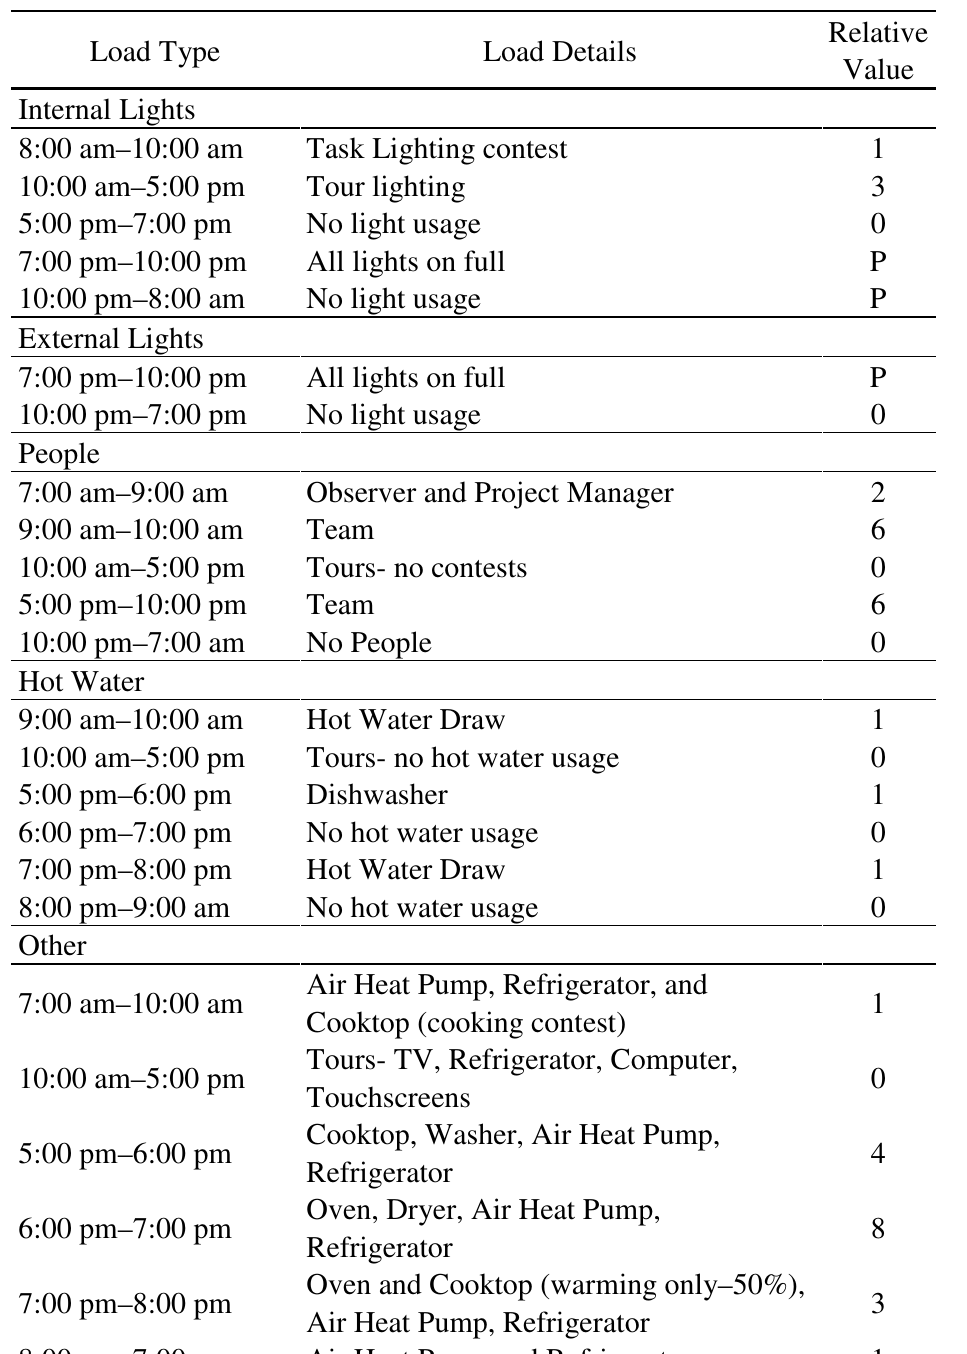
Table 3. Load profile calculations for